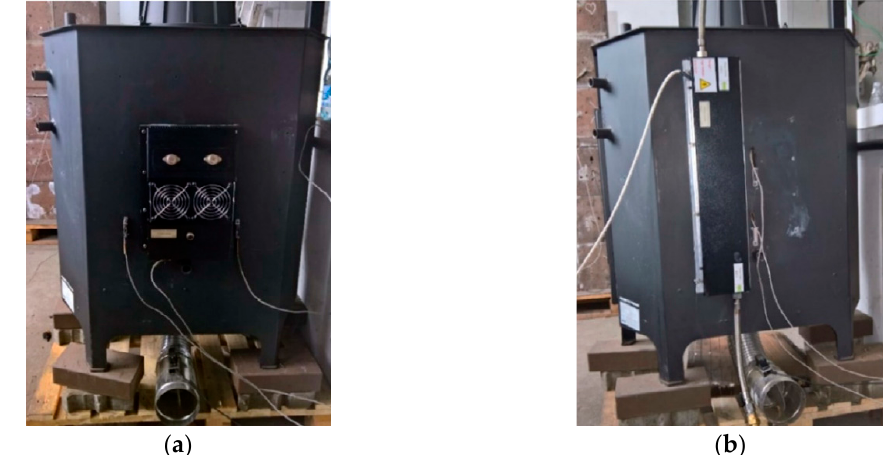
Figure 1. The view of ( a ) the stove with air-cooled TEG1 mounted on its rear wall; ( b ) the stove with water-cooled TEG2 mounted on its rear wall.